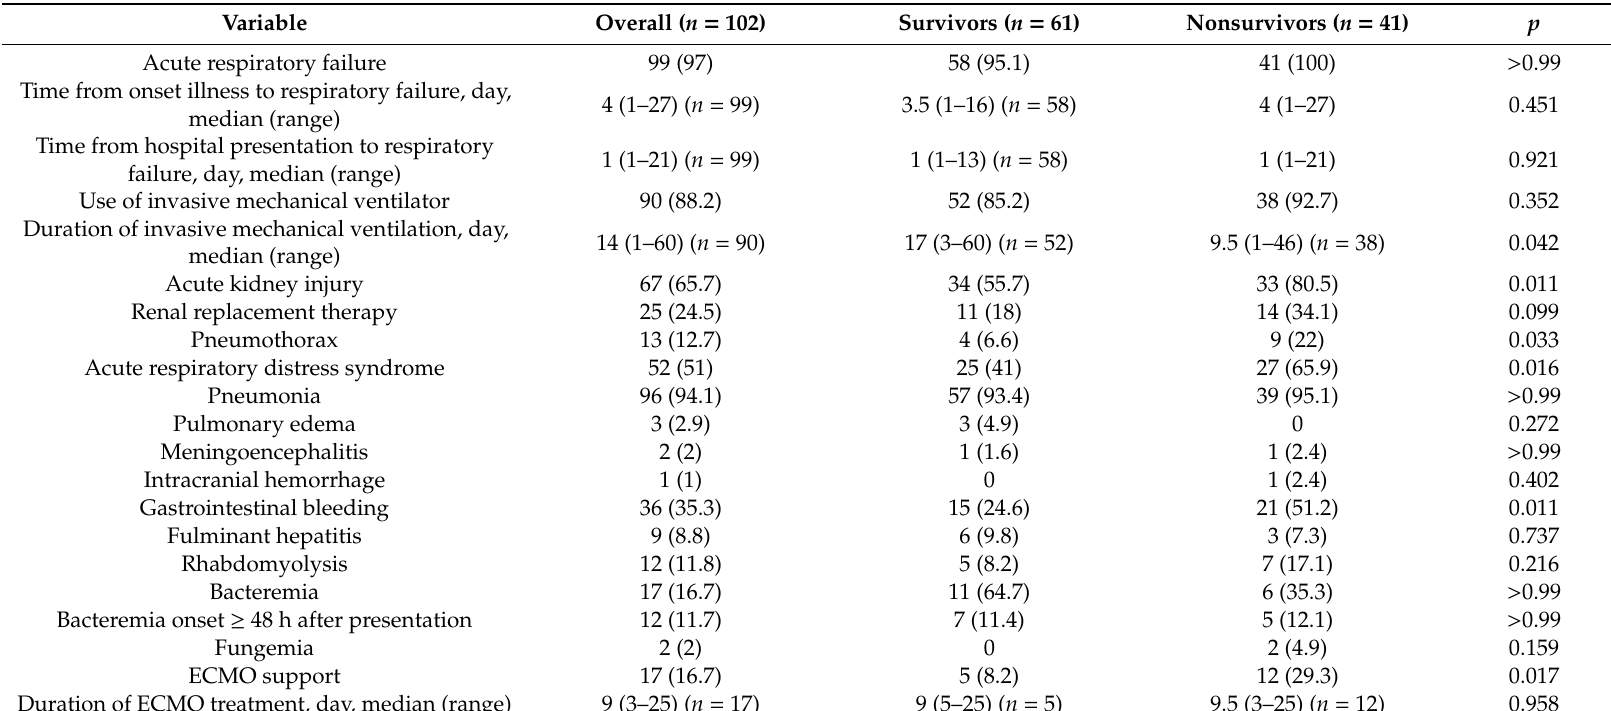
Table 4. In-hospital complications of patients with severe